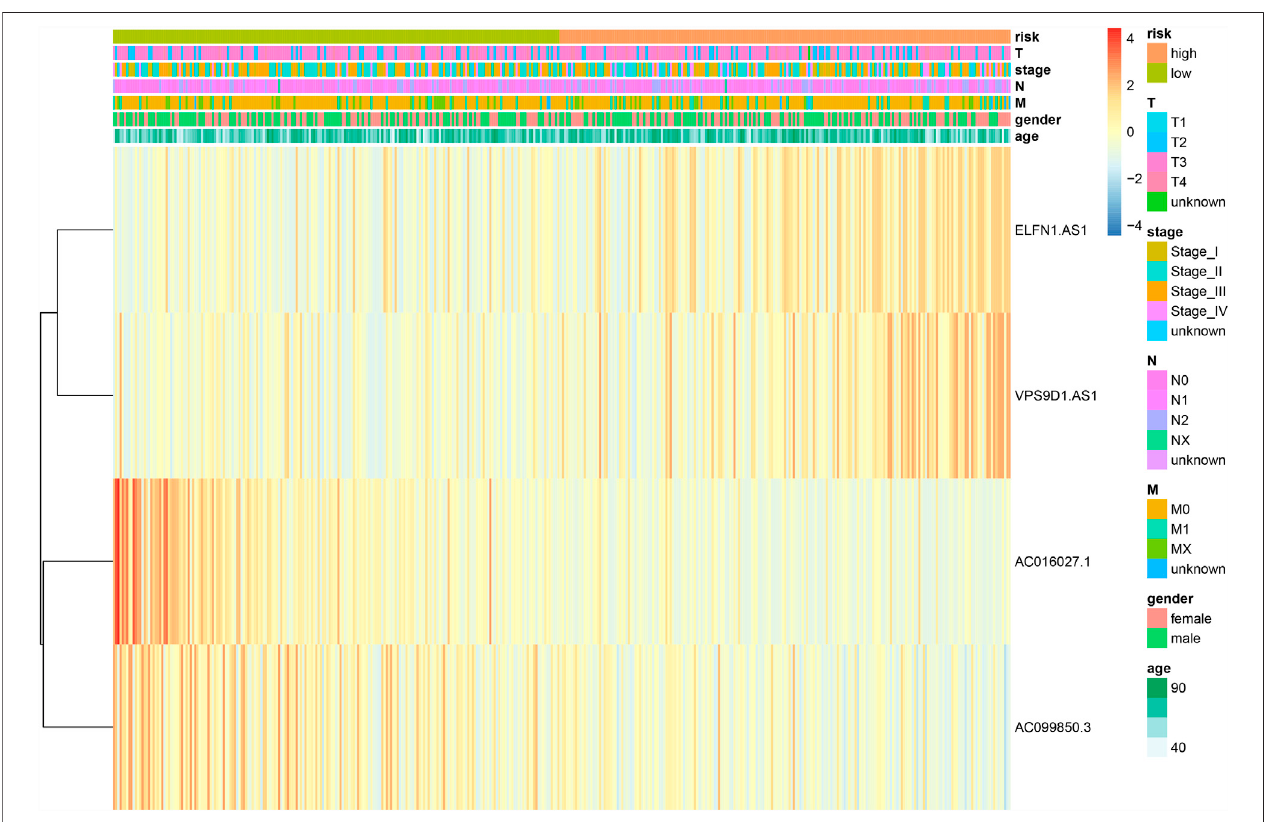
FIGURE 5 | Relationship between the risk score and clinical signi fi cance in training